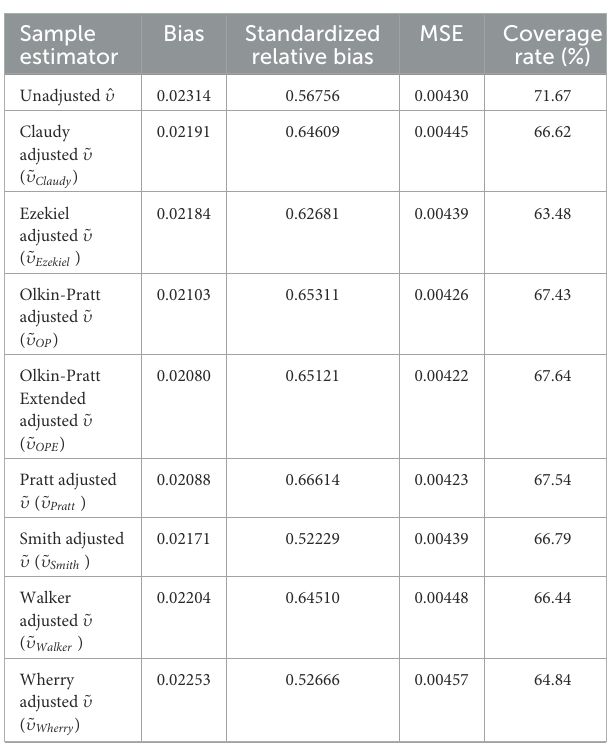
TABLE 2 Formulas of R 2 shrinkage estimators. TABLE 3 Comparison of sample estimators of υ across all